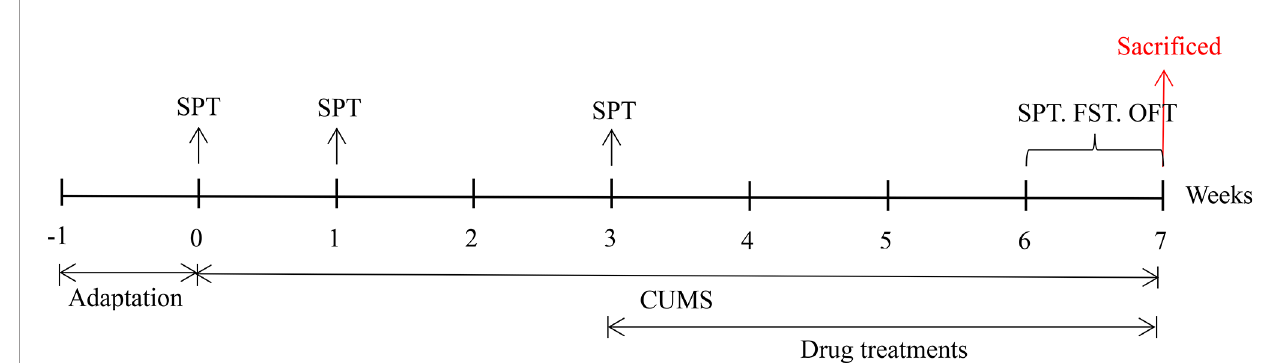
FIGURE 1 | The speci fi c experimental design and implementation. SPT, sucrose preference test; FST, forced swimming test; OFT, open fi eld